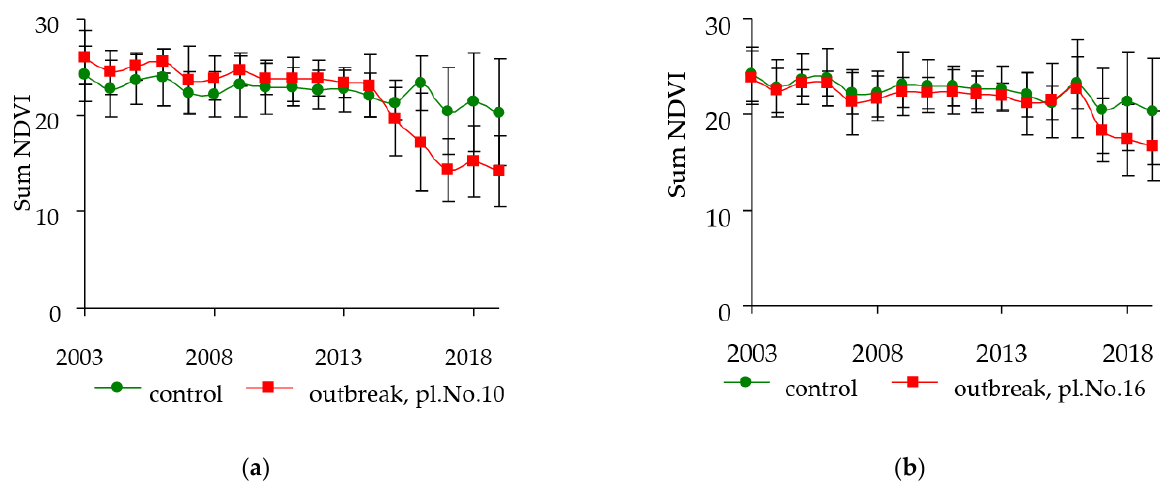
Figure 5. Dynamics of the seasonal NDVI sum in the Siberian silkmoth outbreak and in the control stands for two sample plots ( a ) and ( b ).